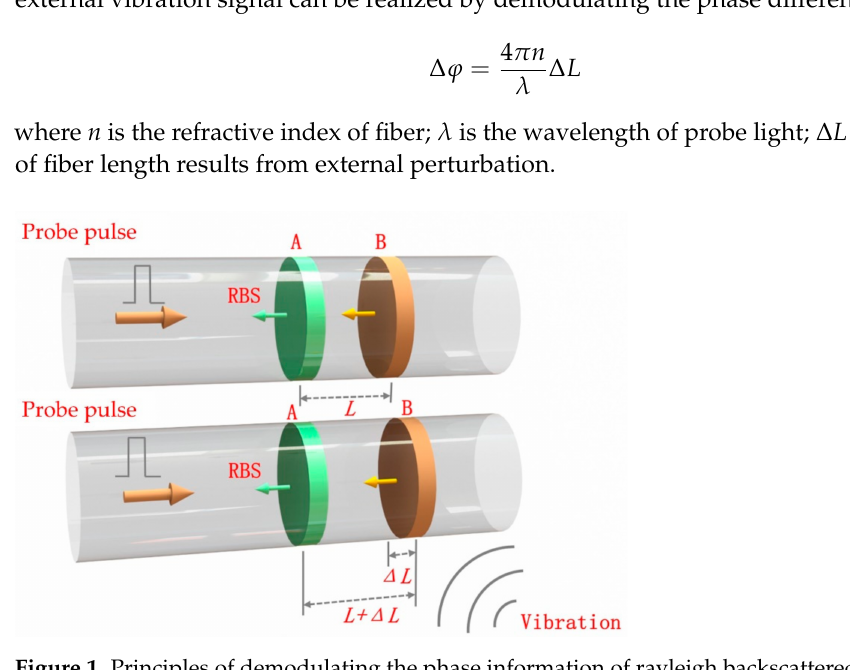
Figure 1. Principles of demodulating the phase information of rayleigh backscattered (RBS)